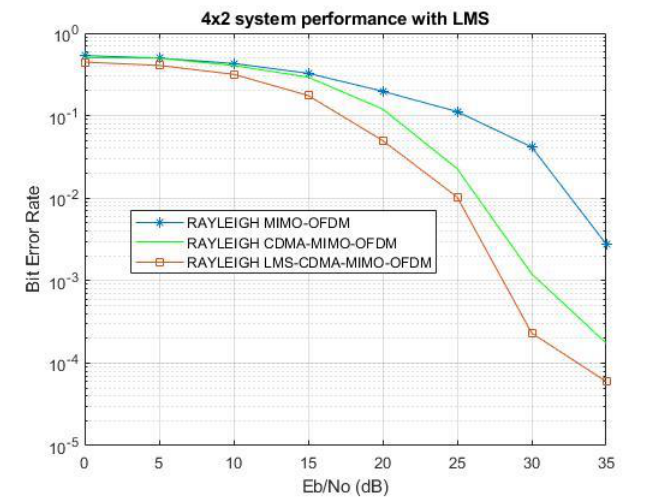
Figure 17. SNR vs. BER plot for 4×2 LMS-MIMO-OFDM model in Rayleigh channel.